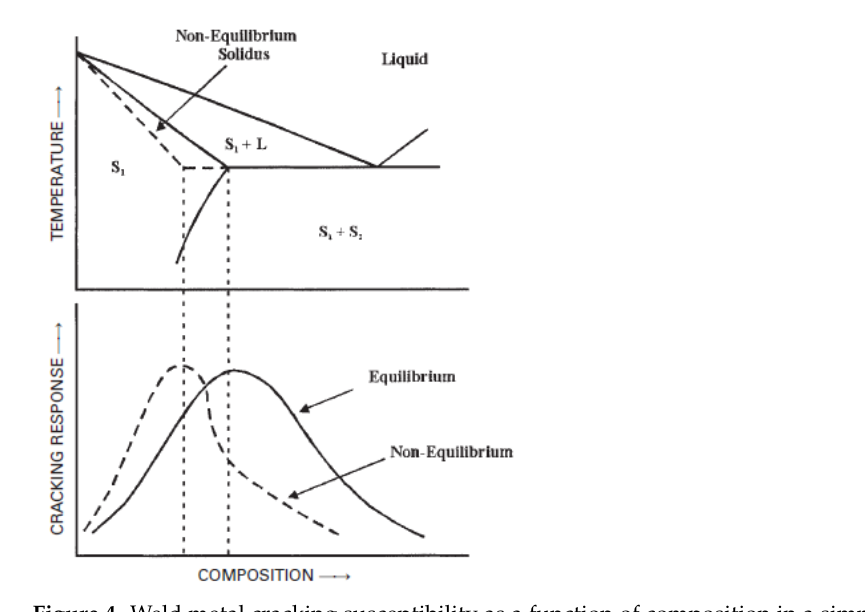
Figure 4. Weld metal cracking susceptibility as a function of composition in a simple binary alloy system: equilibrium and nonequilibrium solidification conditions are considered [93].